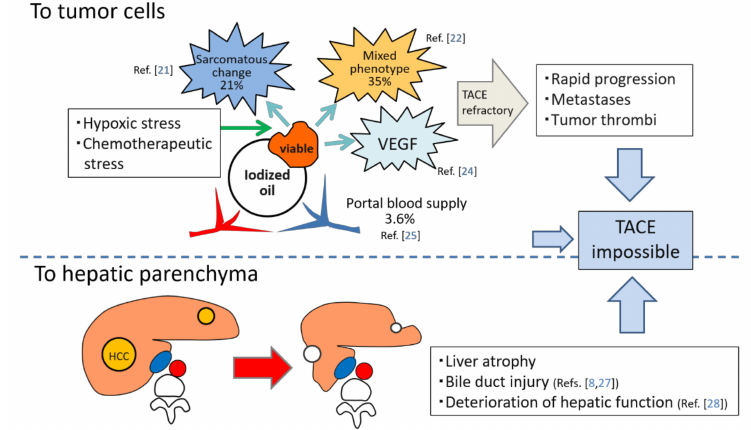
Figure 2. Schematic representation of negative aspects of TACE. Abbreviations: VEGF, vascular endothelial growth